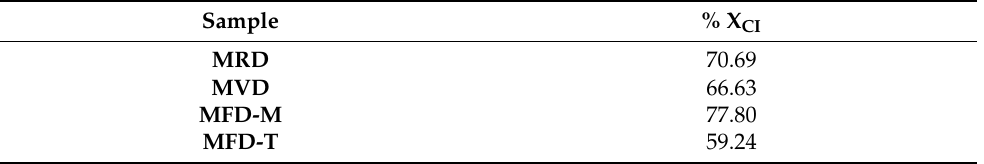
Table 3. Crystallinity index of the PMs and smartcrystals of MLX.